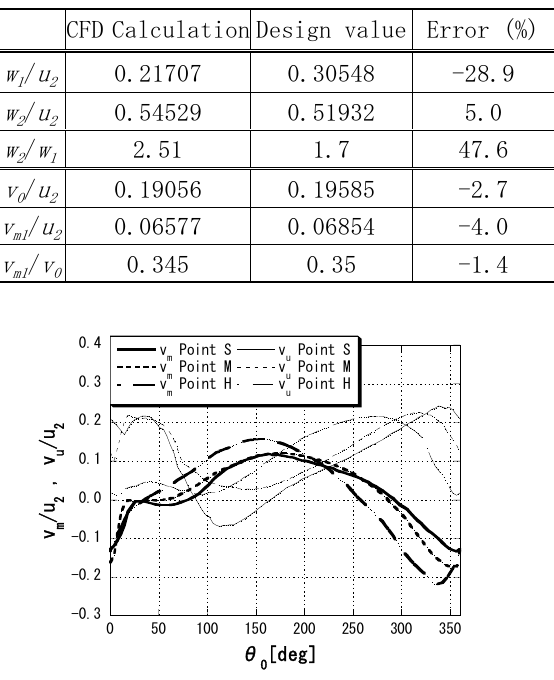
Fig. 9 v m and v u distributions ( φ